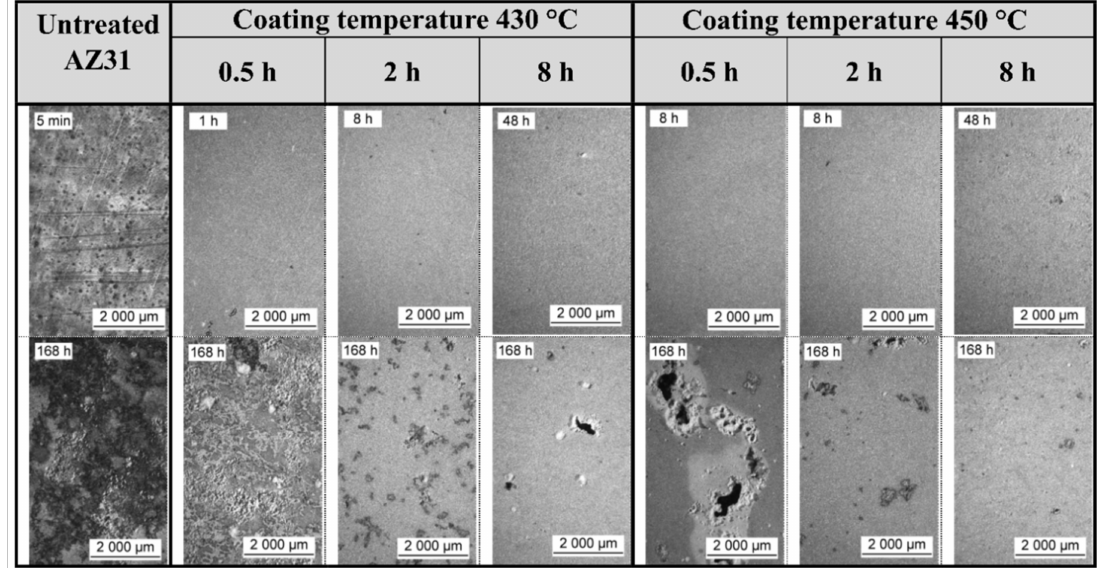
Figure 9. The surface of specimens after the first visual detection of corrosion attack in time and after 168 h of immersion in SBF solution,